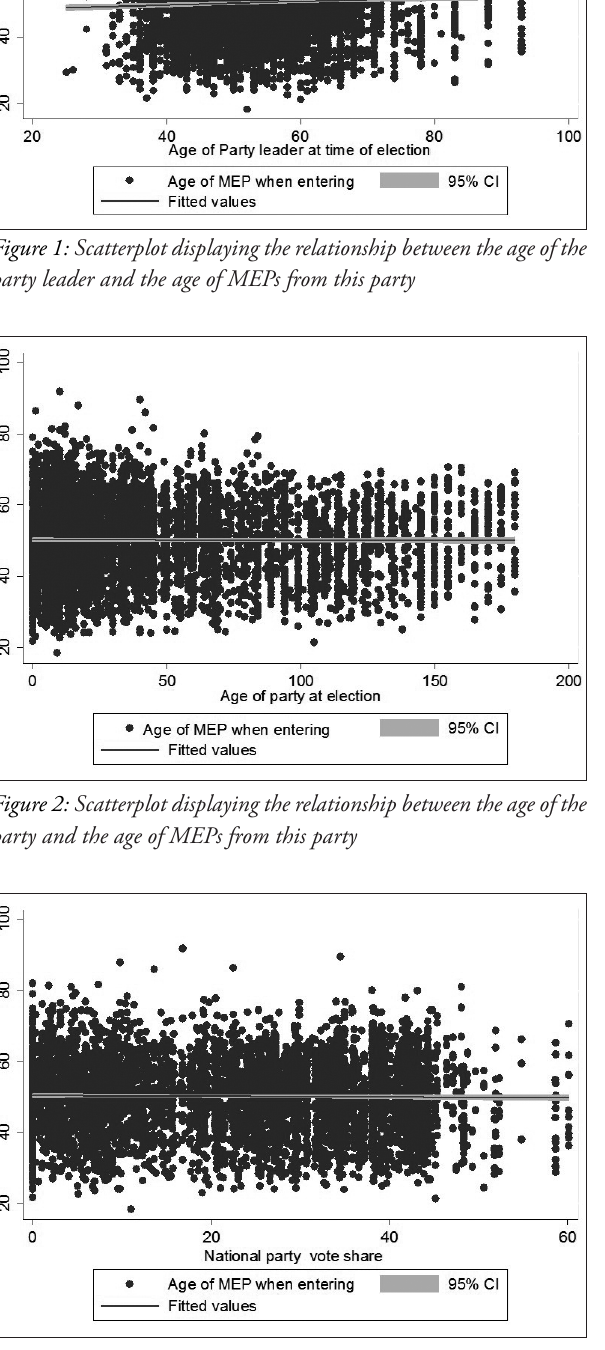
Figure 3: Scatterplot displaying the relationship between the party support size and the age of MEPs from this party